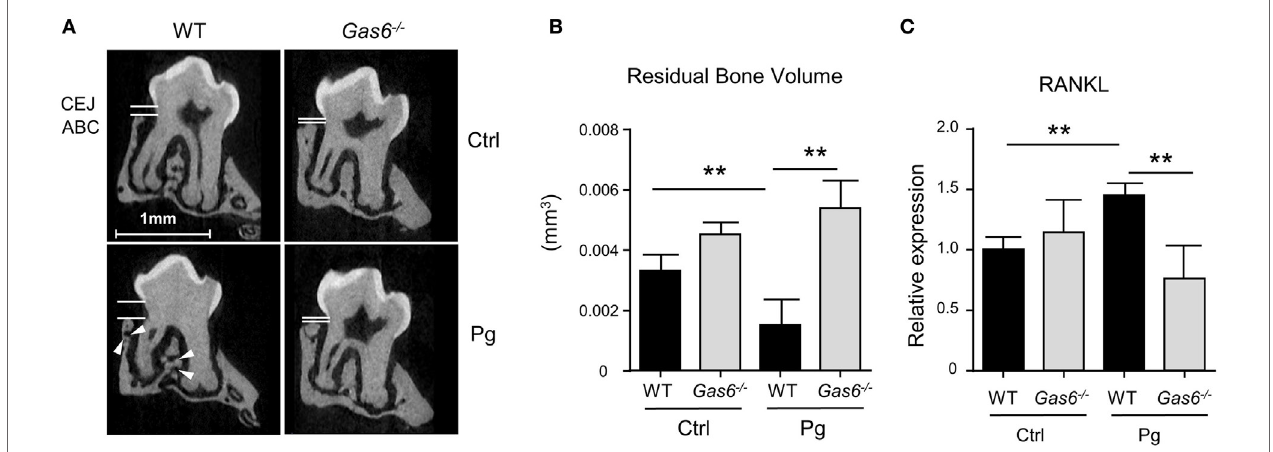
FigUre 2 | Lack of inflammation-induced bone loss in Gas6 − / − mice. (a) Representative μ CT sections of the second upper molar demonstrating the residual bone volume measured from the cemento-enamel junction (CEJ) and alveolar bone crest (ABC). White arrows indicate lesions in the alveolar bone. (B) Three-dimensional quantification of the residual alveolar bone. Data are presented as the volume of alveolar bone in the buccal plate and represent the mean of eight mice per group ± SEM. (c) Quantification by RT- q PCR of the expression levels of RNAKL in the gingiva of infected mice, graphs represent the mean of five mice per group ± SEM. Representative data of one out of two independent experiments is